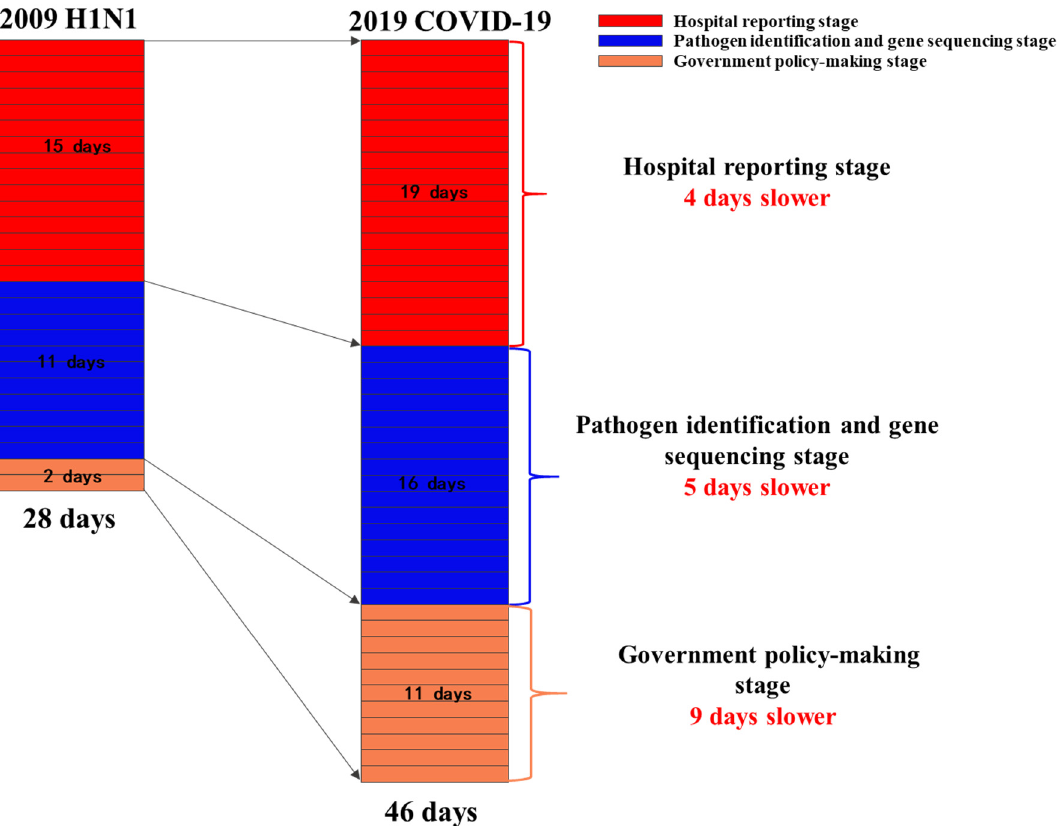
Figure 2. Comparison of three critical speeds between H1N1 swine influenza (2009) and COVID-19.